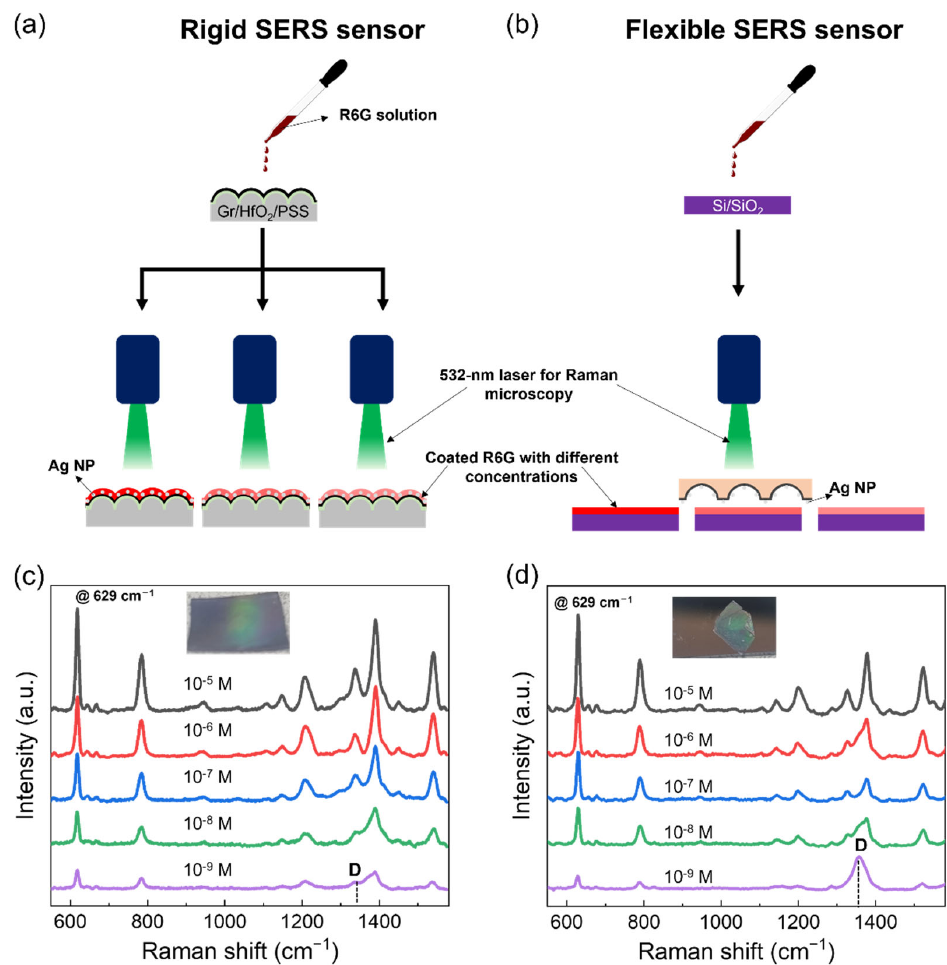
Figure 4. Schematic of R6G detection via SERS analysis with ( a ) rigid and ( b ) flexible SERS sensors based of 3D Gr. Raman spectra of R6G (10 − 5 –10 − 9 M) on the ( c ) rigid and ( d ) flexible SERS